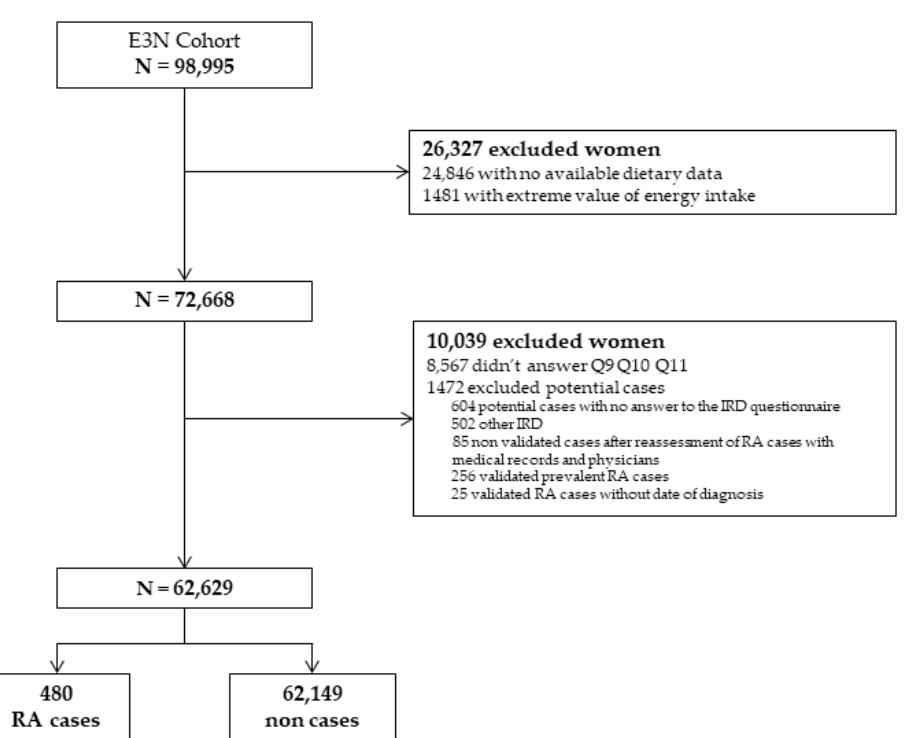
Figure 1. Flow chart of the study. RA: rheumatoid arthritis; IRD: inflammatory rheumatic disease;